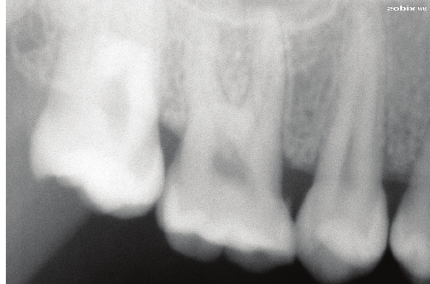
Figure 5: Short crown root length of maxillary I